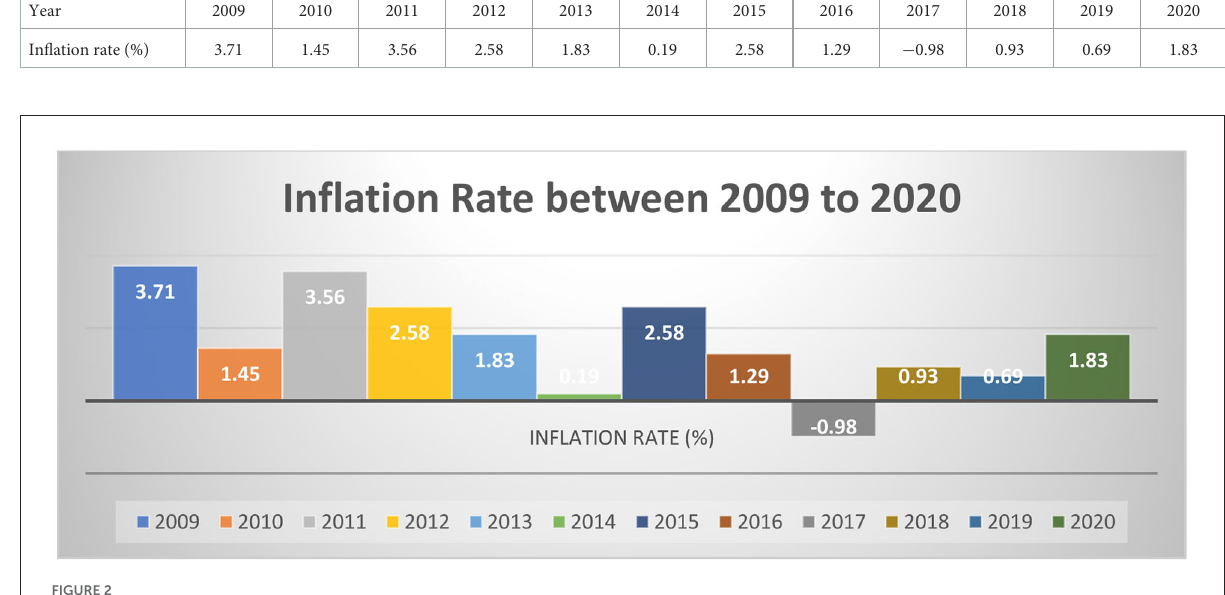
FIGURE2 Togo inflation rate between 2009 and 2020 (World Data,